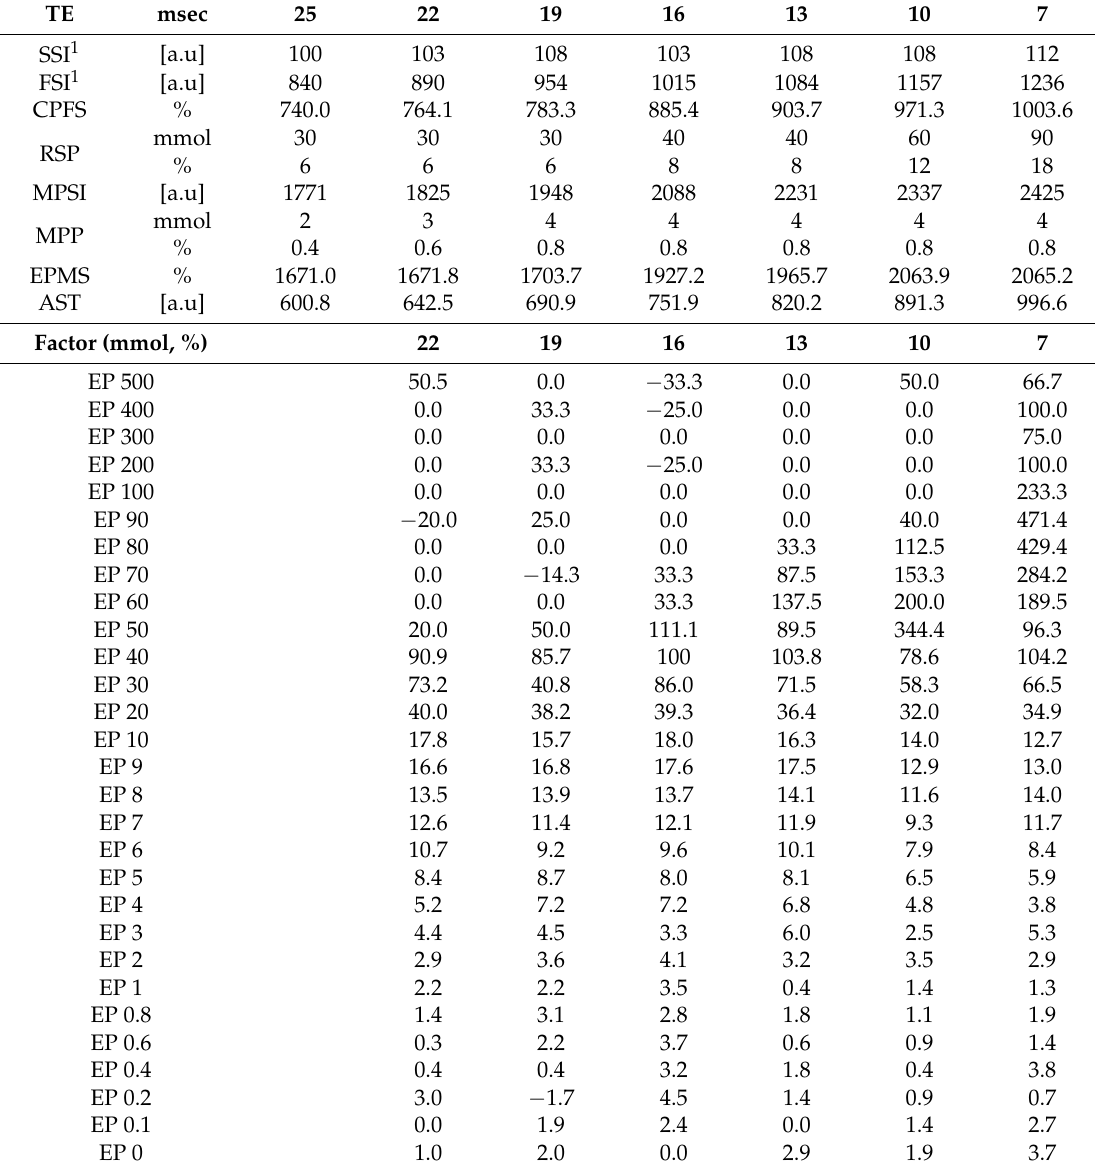
Table 3. Quantitative data for the different evaluation criteria in the phantom